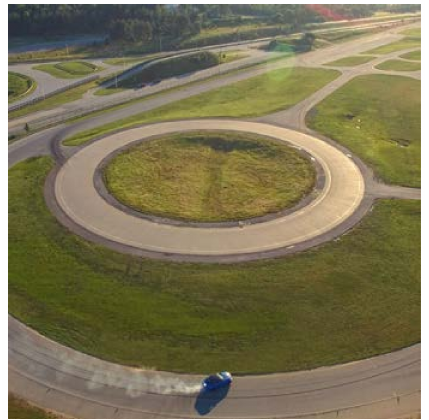
Figure 5. Skid pad (BMW Performance